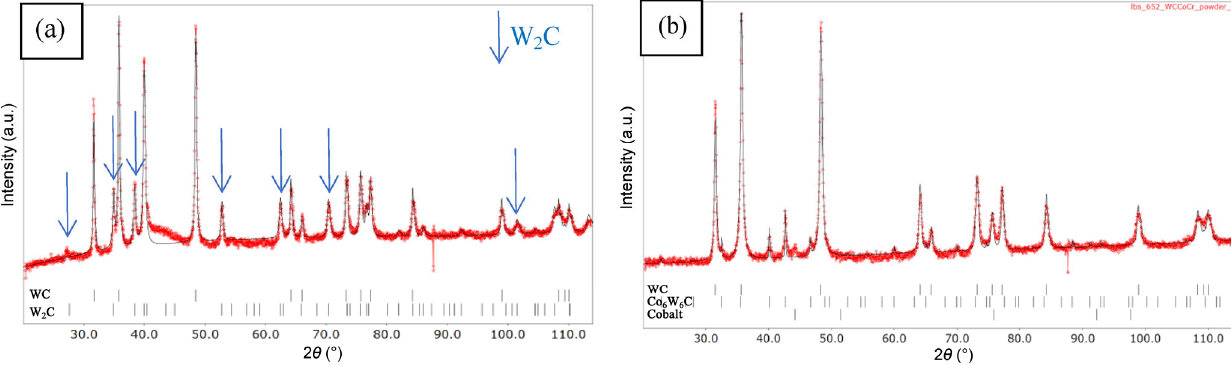
Fig. 3 (a) XRD of the HVOF coating and (b) initial